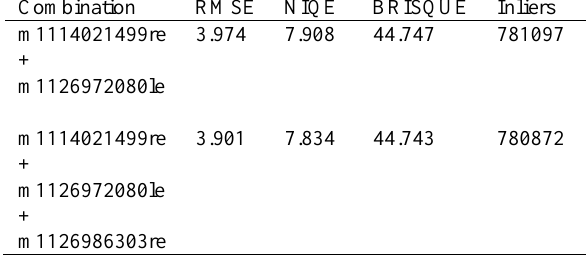
Table 4. Evaluation of different